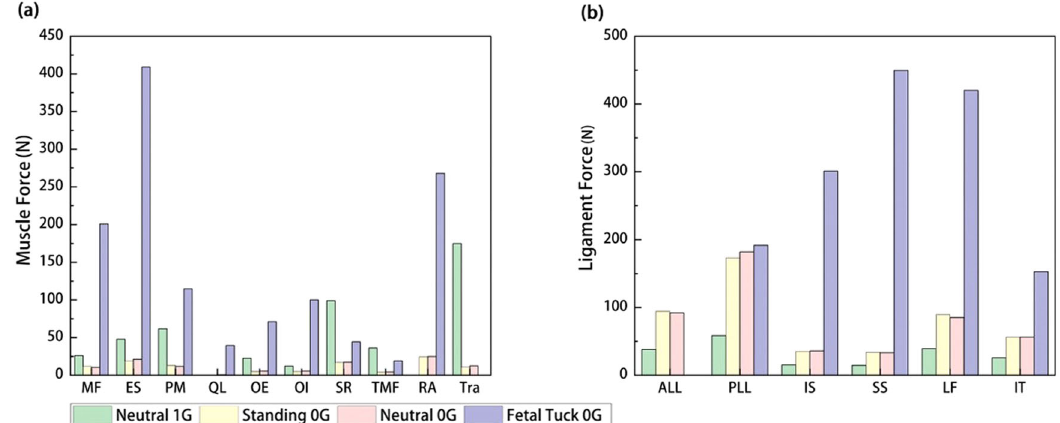
Fig. 5 Comparison of muscle forces and ligament forces in lumbar spine among various postures in 1G gravity and microgravity. a Muscle forces and b ligament forces in lumbar spine among Neutral 1G, Standing 0G, Neutral 0G, and Fetal Tuck 0G. MF multi fi dus, ES erector spinae, PM psoas major, QL quadratus lumborum, OE obliquus externus, OI obliquus internus, SR semispinalis, TMF thoracic multi fi dus, RA rectus abdominis, Tra transversus abdominis, ALL anterior longitudinal ligament, PLL posterior longitudinal ligament, IS interspinous, SS supraspinous, FL fl avum, IT